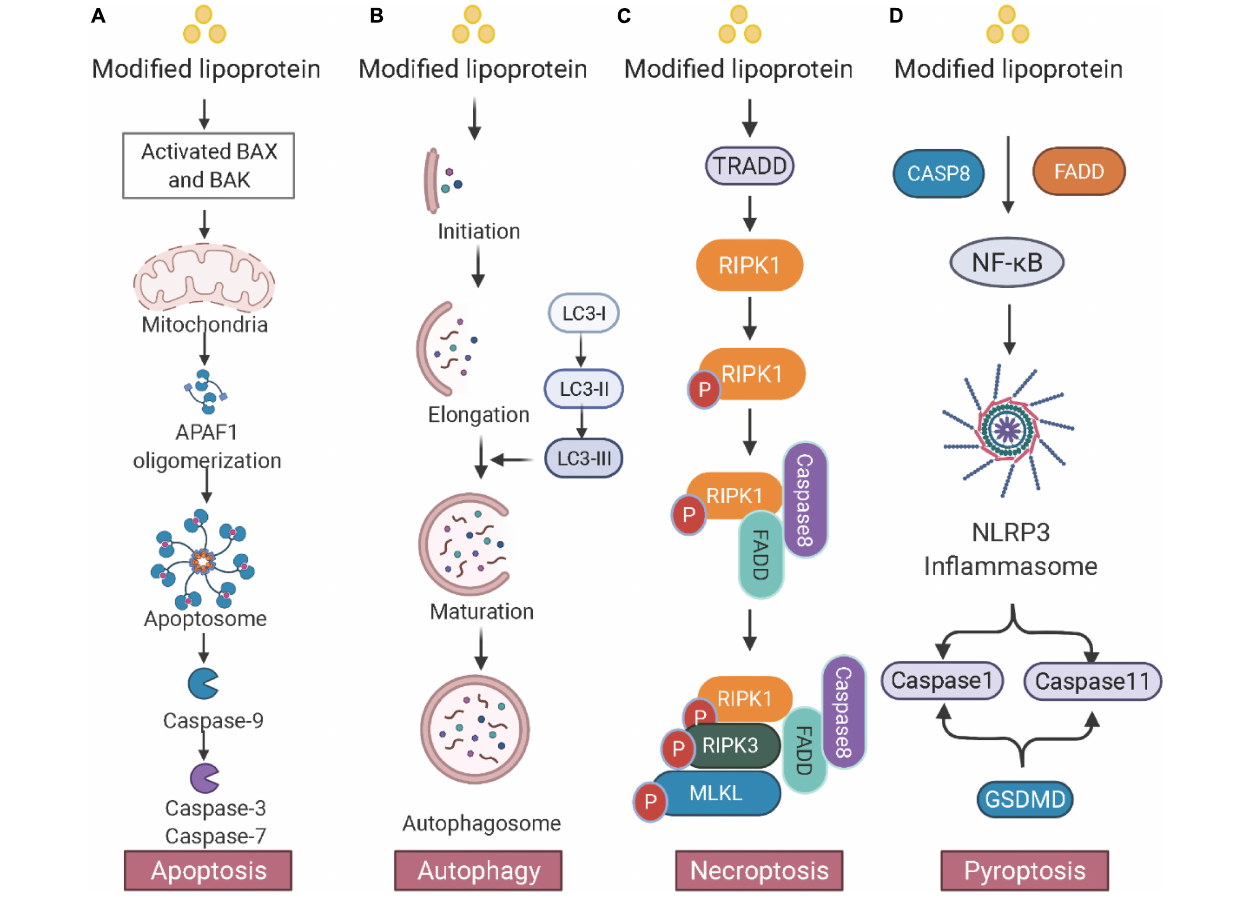
FIGURE 2 | Consequences of foam cells in atherosclerosis. (A) Apoptosis: The mitochondrial intermembrane protein is released and triggers apoptotic protease activating factor 1 (APAF1) and apoptosome, leading to DNA fragmentation. (B) Autophagy: Double membrane autophagosomes are fused with lysosomes for degradation. The microtubule-associated protein 1A/1B light chain 3 (LC3) conjugation system participates in the membrane elongation and formation of the autophagosome. (C) Necroptosis: Activated TRADD (TNFRSF1A associated via death domain) triggers the phosphorylation of RIPK1 and RIPK3 and induces the downstream MLKL. (D) Pyroptosis: Inflammatory stimuli activate the NF- κ B pathway and the NOD-like receptor 3 (NLRP3) inflammasome. NLRP3 then causes pyroptosis through caspase-1- and caspase-11-mediated cytoplasmic protein gasdermin D (GSDMD). Created with